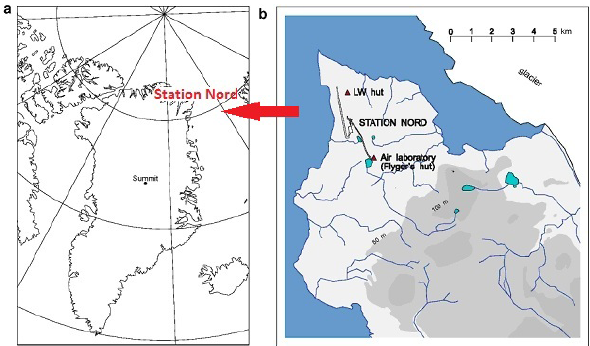
Fig. 1. (a) Greenland with the location of Station Nord and (b) the position of the air monitoring site Flyger’s Hut at Station Nord (Hei- dam et al., 1999).